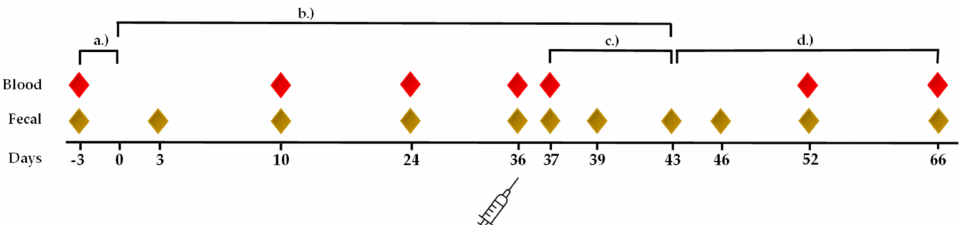
Figure 1. Timeline and sampling days of the trial. Blood samples (red diamond) and fecal samples (brown diamond) were collected on the indicated days. ( a ) day − 3 to 0 before supplementation. ( b ) day 1–43, the horses received the SCF product (OLI, n = 6) or a placebo (PLA, n = 5) during supplementation. ( c ) day 37–43 after vaccination. ( d ) day 43–66, the horses received no supplemen- tation (after supplementation period). On day 36, the horses were vaccinated parenterally against equine